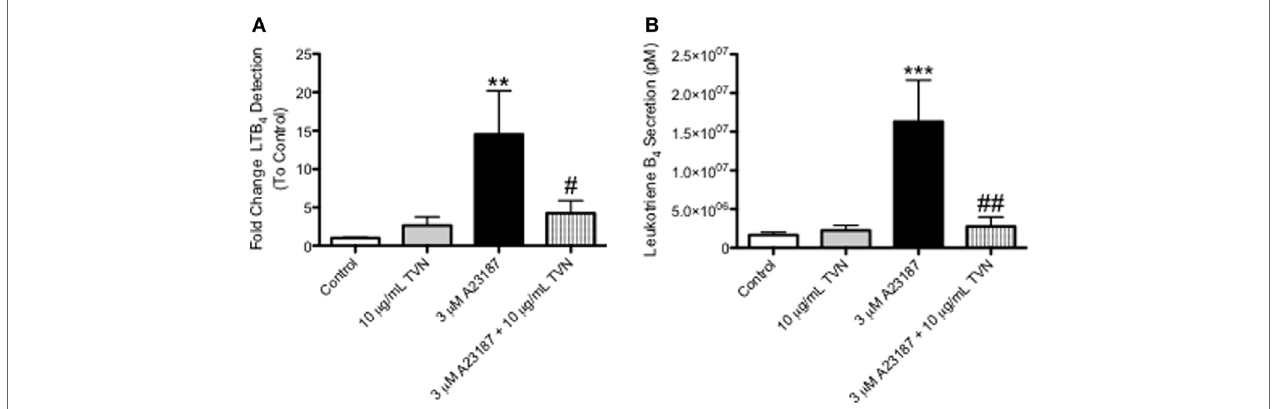
FigUre 5 | Tylvalosin inhibits the production of the pro-inflammatory lipid mediator LTB 4 , in calcium ionophore-activated porcine neutrophils. (a) Secreted levels of LTB 4 from porcine neutrophils treated with 10% HI-FBS in HBSS (control) or 10 μ g/mL TVN in the presence or absence of 3 μ M calcium ionophore A23187 for 0.5 h were measured using reverse phase- high performance liquid chromatography (RP-HPLC). Values represent fold change of LTB 4 peak integration values generated from arbitrary units on sample specific chromatograms where intensity correlated to LTB 4 concentration. Data represent mean ± SEM ( n = 7–10/group). ** P < 0.01 versus unstimulated control; # P < 0.05 versus 3 μ M A23187. (B) Porcine neutrophils underwent these same treatments for 0.5 h and LTB 4 release was measured using liquid chromatography-mass spectrometry (LC/MS). Values represent LTB 4 levels in pM calculated from standard curves generated by integrating the area under the curve of elution peaks where intensity correlated to known LTB 4 concentrations. Data represent mean ± SEM ( n = 10–15/group). *** P < 0.001 versus unstimulated control; ## P < 0.01 versus 3 μ M